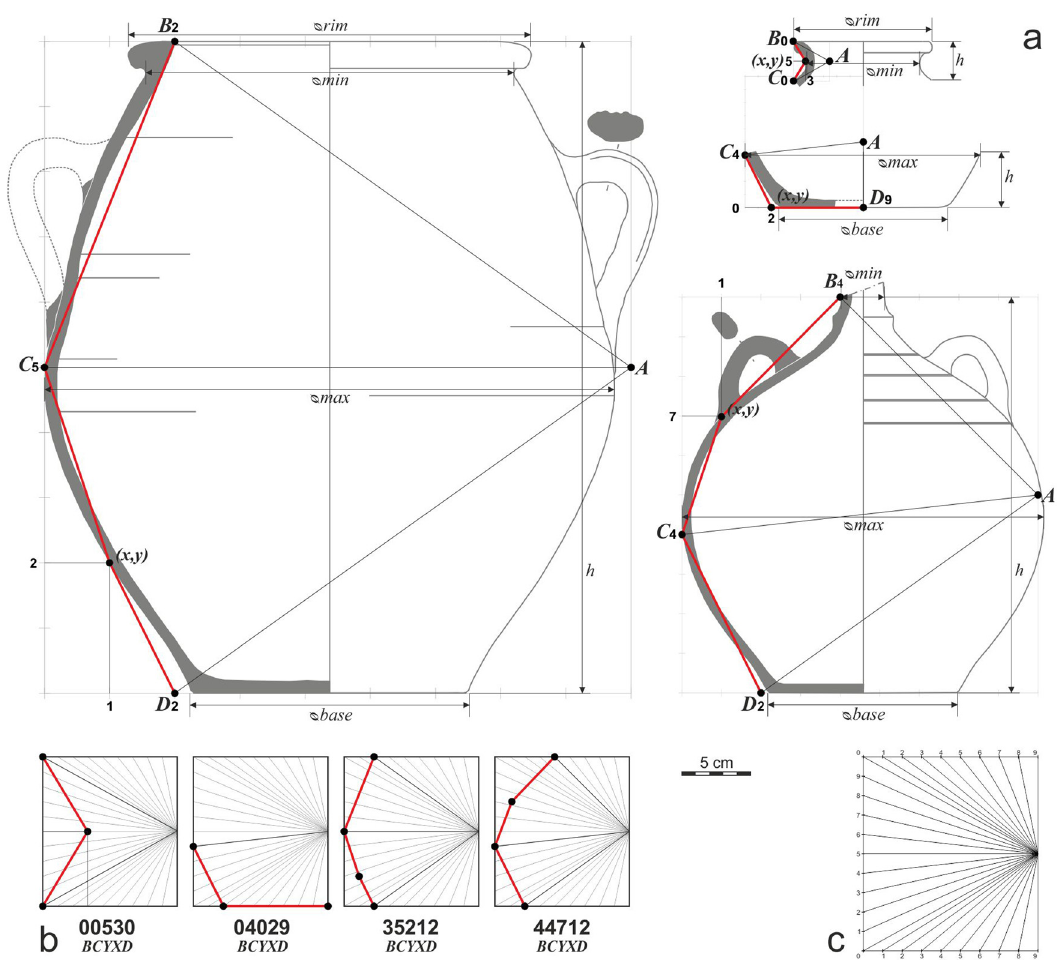
Figure 3: Examples of data measurement on several entire and broken vessels ( a ) , standardization of pro fi les for these same vessels ( b ) , and pattern for vector pro fi le measurement according to Llanos and Vegas ( 1974 ) ( c )